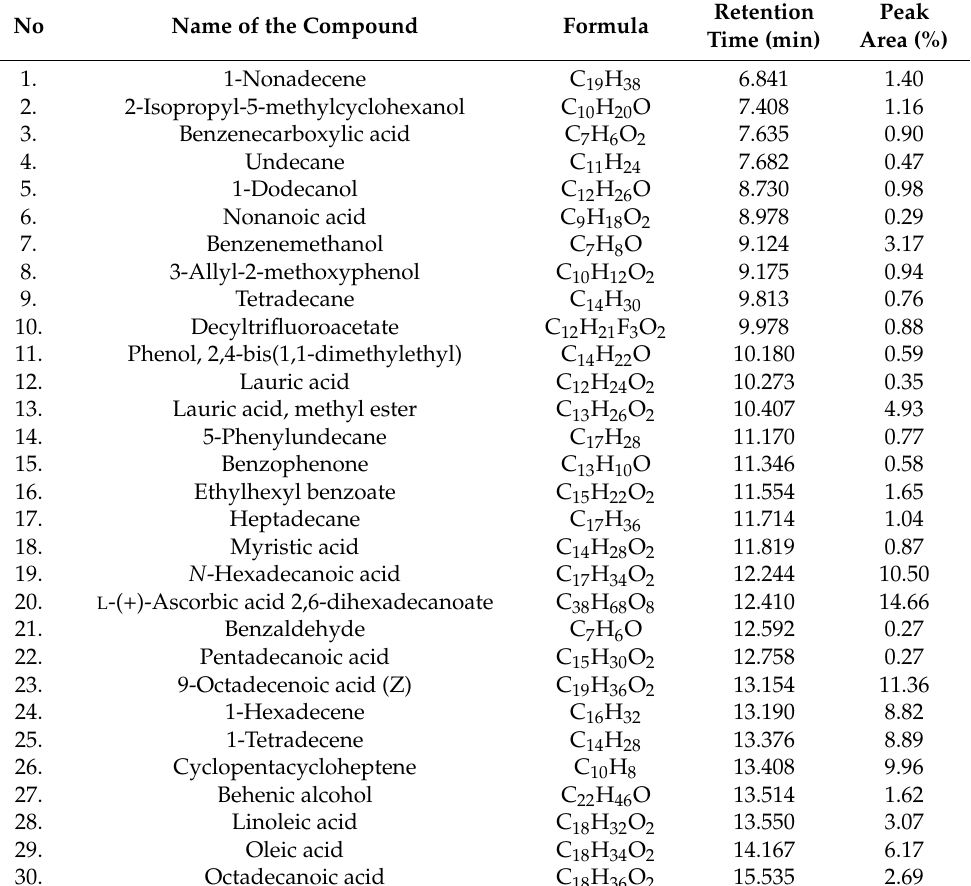
Figure 4. The GC-MS chromatogram of the optimized red pitaya peel extract. Table 4. The compound composition of red pitaya peel extract by GC-MS as per NIST library. No Name of the Compound Formula Retention Time (min) Peak Area (%)